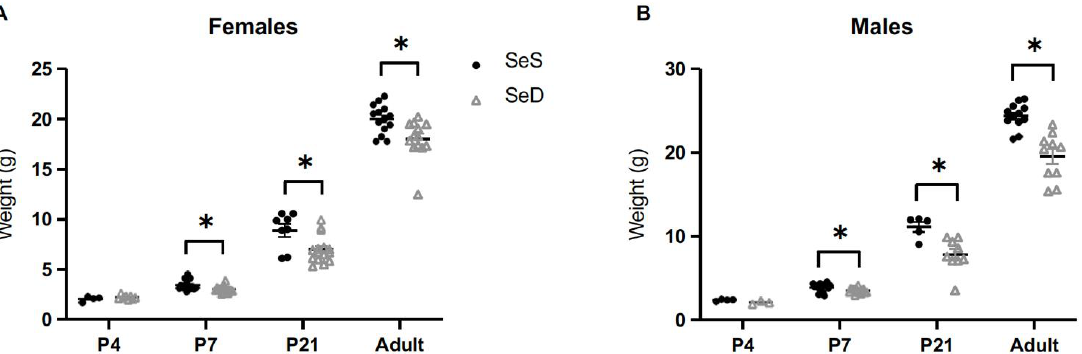
Figure 1. Neonatal Se deficient mice exhibit lower weights than Se sufficient mice from postnatal day 7 through adulthood. C57Bl/6 mice were placed on diets that differed only in Se content, either 0.4 ppm or <0.01 ppm of sodium selenite, through pregnancy and lactation. After weaning, pups were continued on their respective SeS or SeD diets. Female and male offspring were weighed at postnatal day 0, 4, 7, 21 and 8 – 10 weeks of life. ( A ) Weights for female mice ( B ) Weights for male mice N = 4 – 15 for all groups. Data are presented as mean (±SEM), * p < 0.05 vs. age-matched SeS control by Students two-sided t -test.